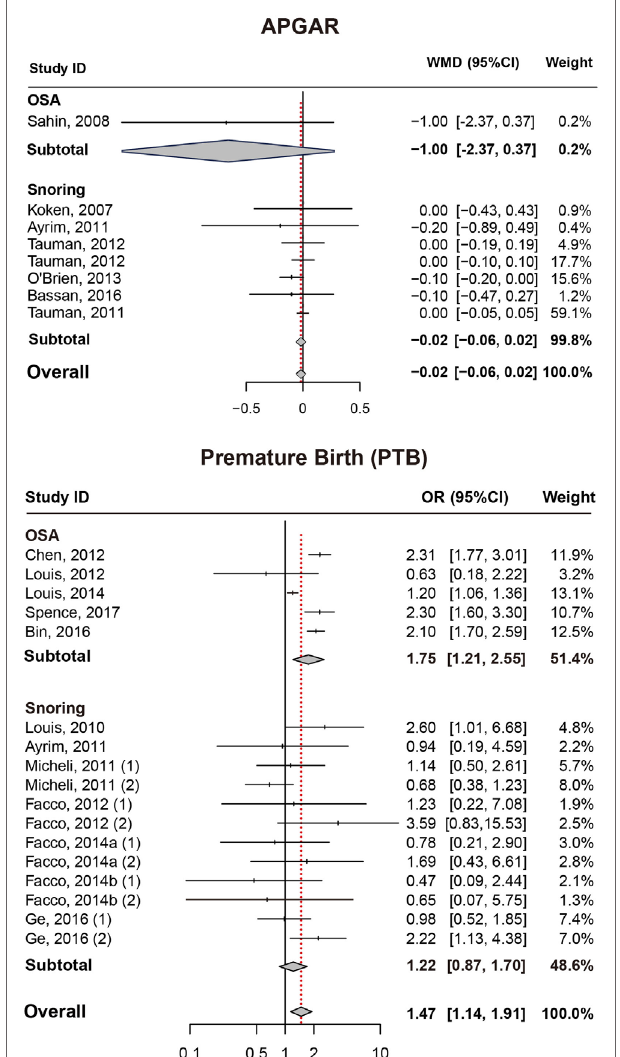
FigURe 4 | Forest plot of the association between APGAR/PTB and SDB (snoring and OSA). Results are expressed as OR or WMD with 95% CI. APGAR, APGAR score; PTB, preterm birth; SDB, sleep-disordered breathing; OSA, obstructive sleep apnea; OR, odds ratio; WMD, weighted mean difference; CI, confidence interval. The numbers after authors were used to distinguish different groups within one